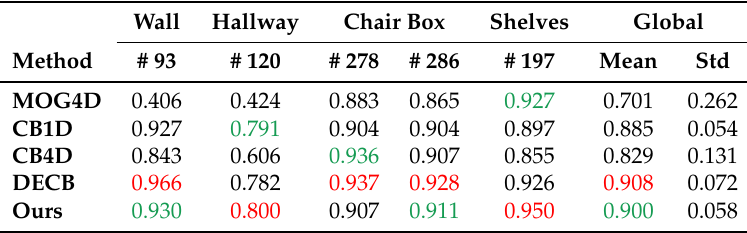
Table 1. Quantitative evaluation results using Fernandez’s Kinect dataset. Red text indicates the best, and green text indicates the second best F 1 score. MOG, mixture of Gaussians; CB, codebook; DECB, depth-extended